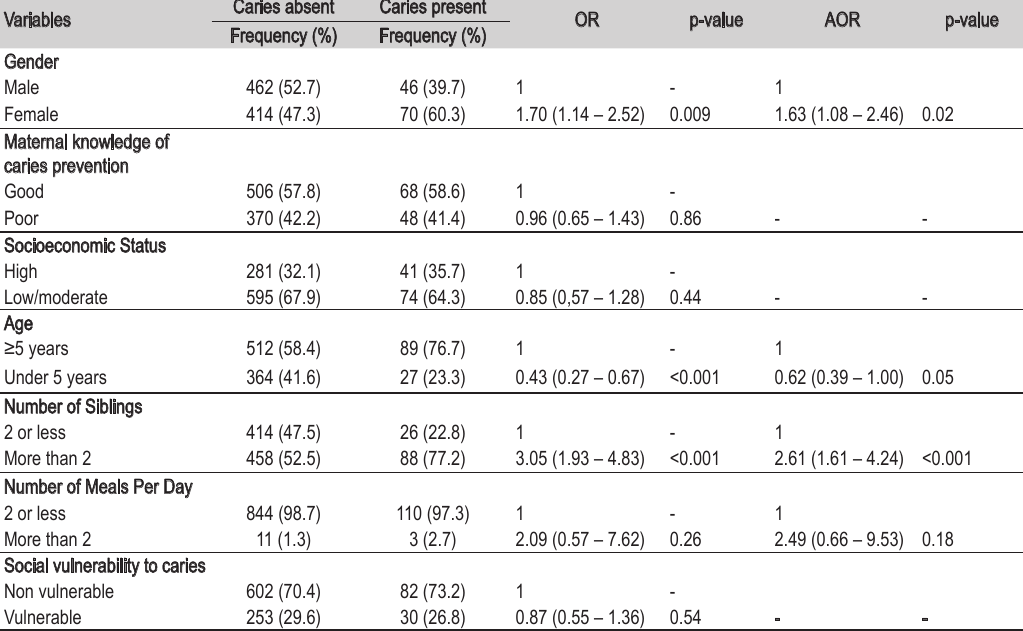
Table 5 - Frequency distribution and results of logistic regression analysis for predictors of caries status in a sample of 992